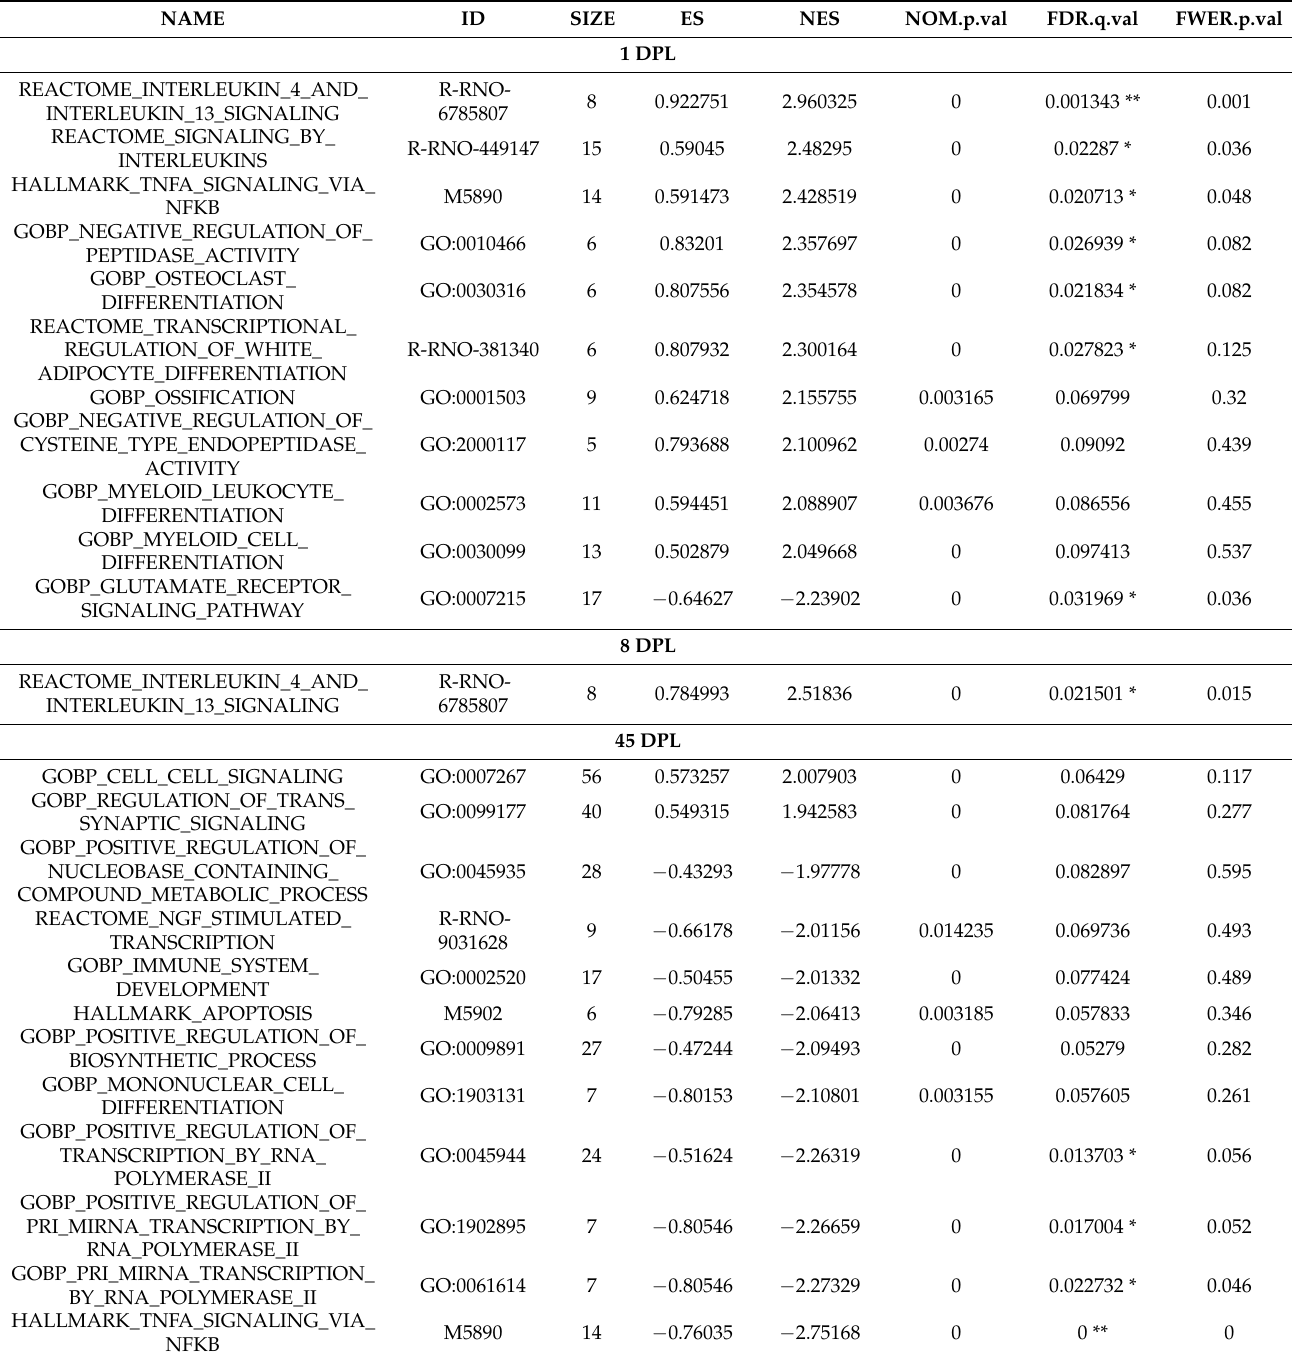
Table 1. Early (1, 8 DPL peak) and late (45 DPL peak) profiles deregulated pathways in the Spinal Cord segment rostral to the